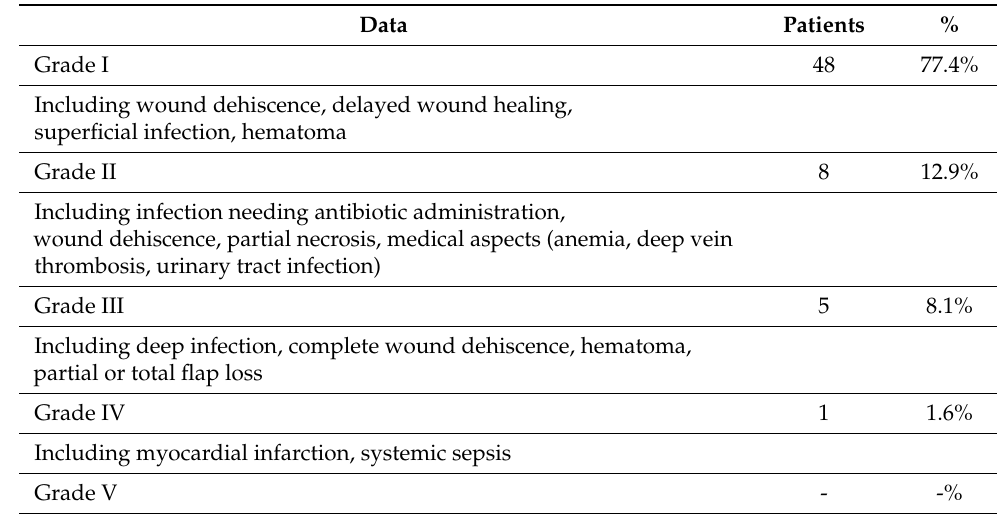
Table 4. Complications of 62 patients (38.5%) classified according to the Clavien–Dindo